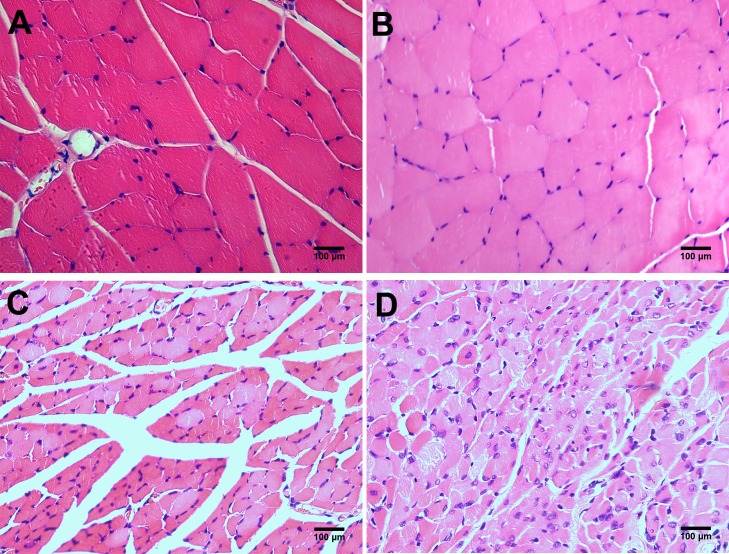
H&E staining of the tibialis anterior muscles 28 days post-surgery.The skeletal muscles were well preserved in morphology and structure, and staining was well distributed in group NC (A) and HI (B). The skeletal muscles were reduced in volume, and the staining was inhomogeneous in group HD (C). The skeletal muscles were reduced in volume severely and disorganized in morphology and structure, and the nuclei were enlarged and located abnormally in group HID (D).